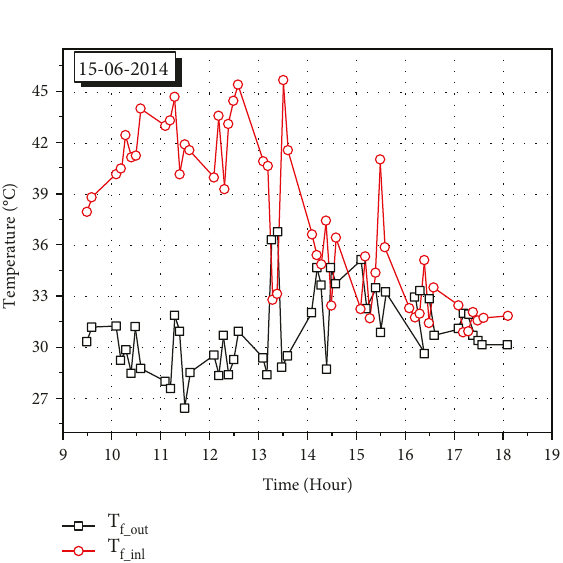
Figure 7: Photo of the experimental prototype.